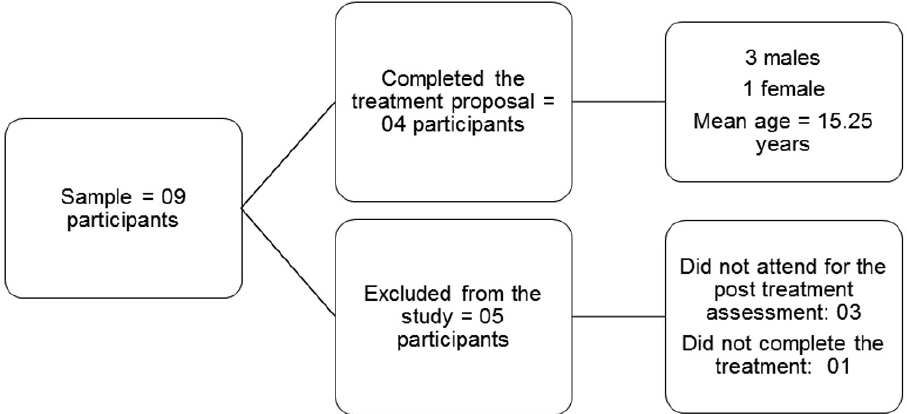
Figure 2 - Sample